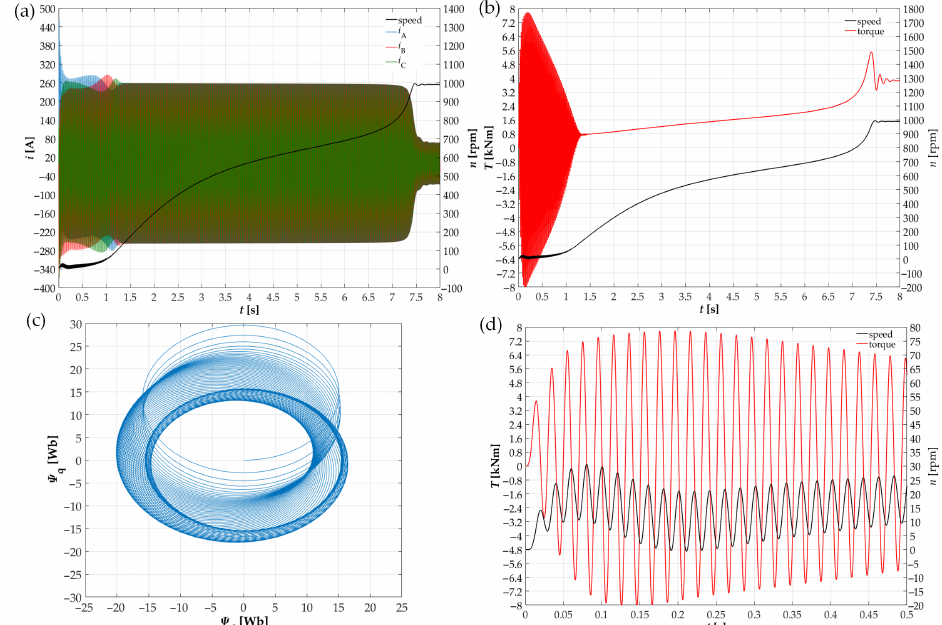
Figure 13. Waveforms of physical quantities for direct starting, with no voltage phase delay and fan (cid:1) 2 (cid:0) n load torque T o = 59 + 3800 : ( a ) time waveforms of the stator currents in three phases and rota- 990 tional speed; ( b ) time waveforms of the electromagnetic torque and rotational speed; ( c ) hodograph of stator fluxes; ( d ) fragment of the time waveform of the electromagnetic torque and rotational speed in the first moment of starting.